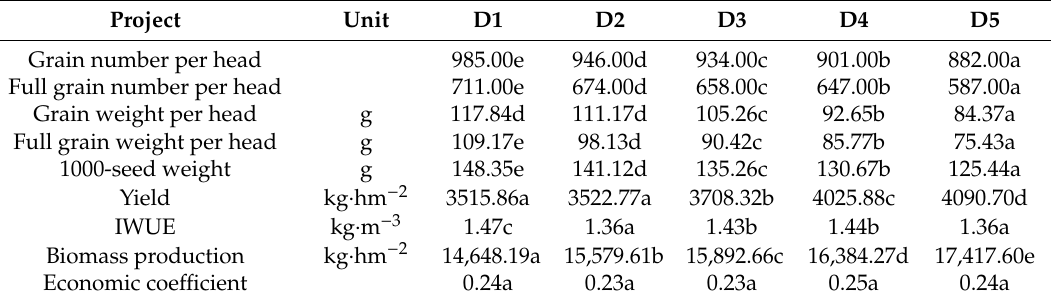
Table 9. Yield attributes in